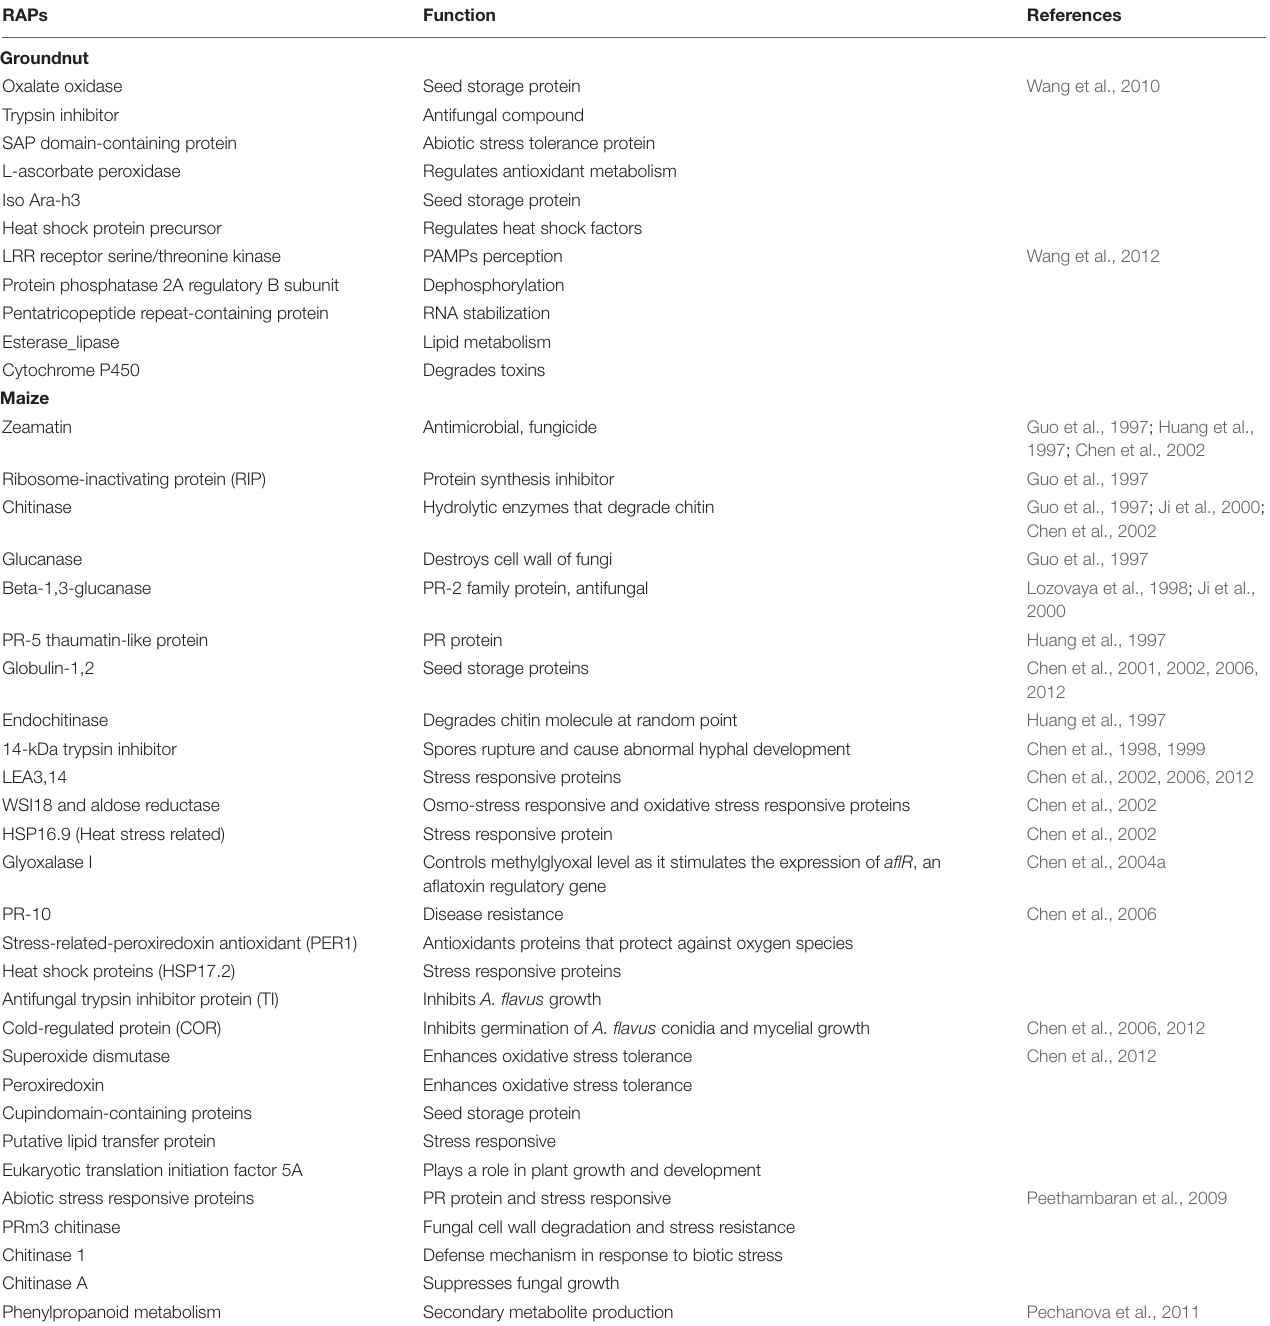
TABLE 2 | List of key proteins and their functions associated with resistance to aflatoxin contamination in groundnut and maize. RAPs